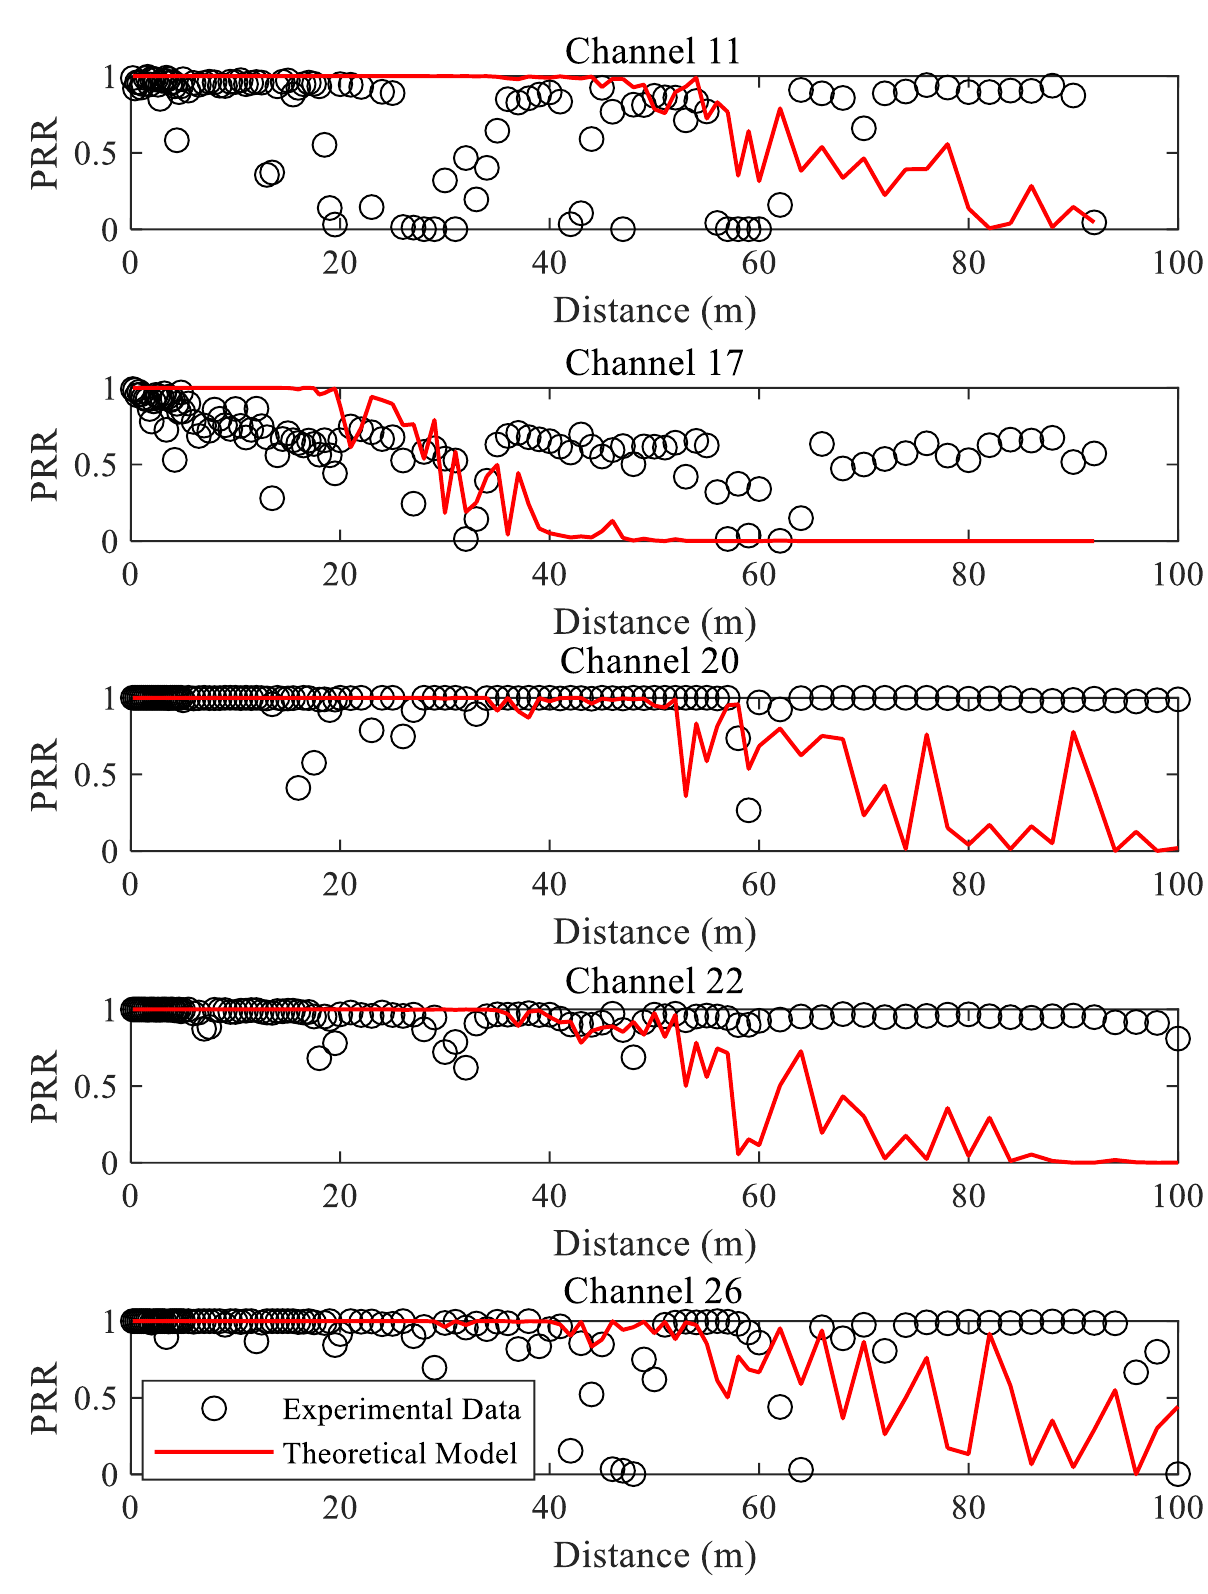
Figure 3. PRR and its spatial distribution model under different channels.